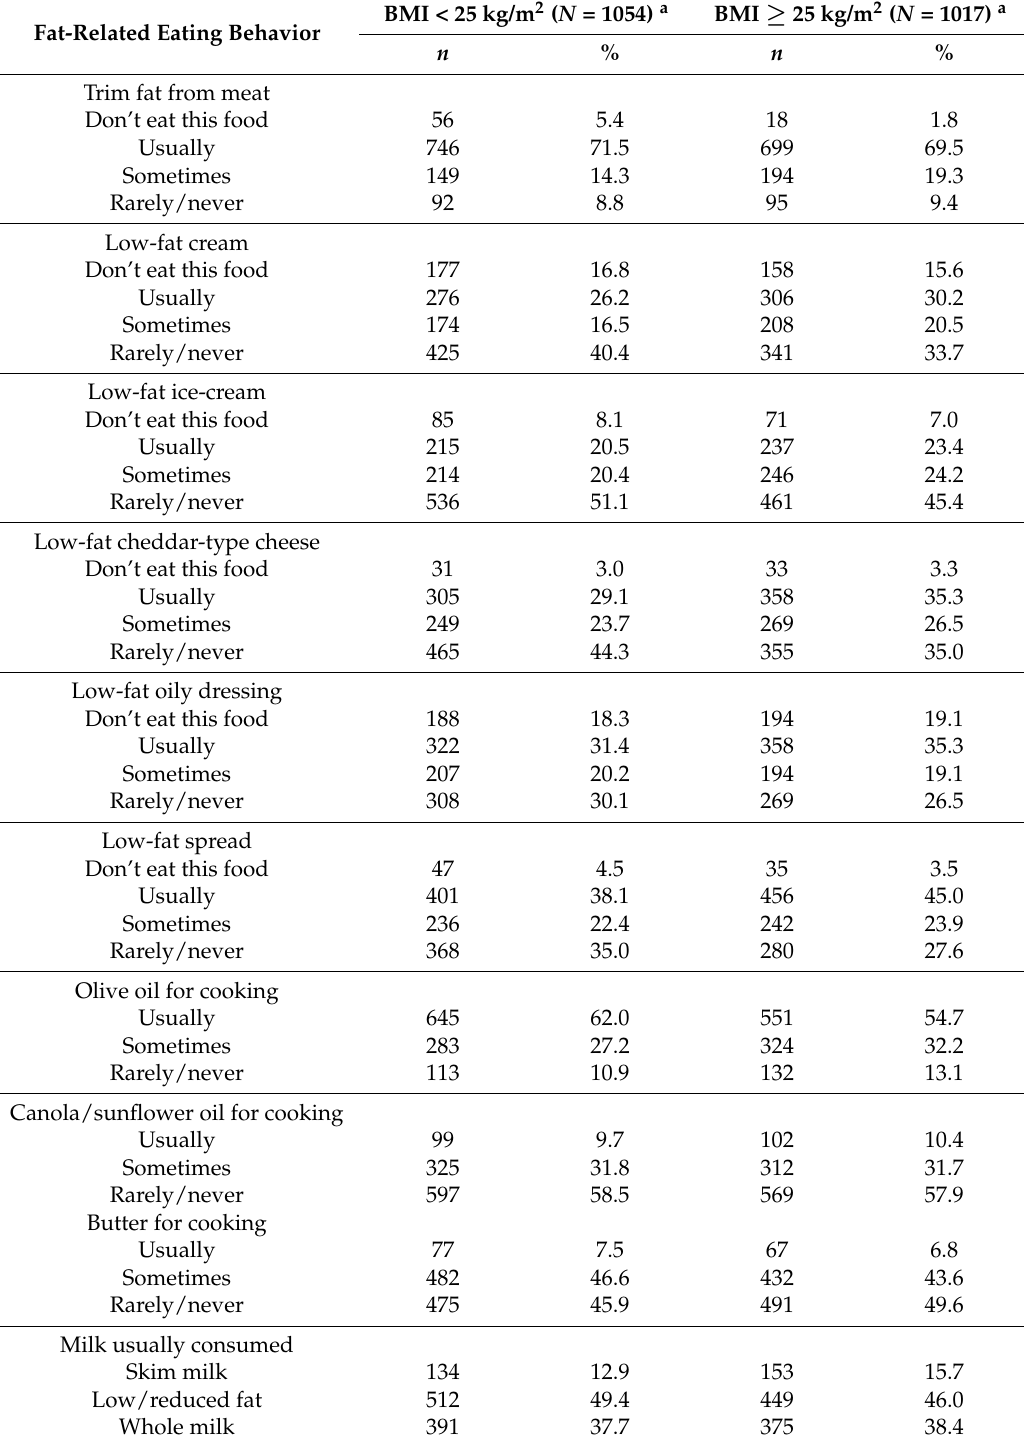
Table 2. Distribution of fat-related eating behaviors, stratified by weight status, from the Childhood Determinants of Adult Health